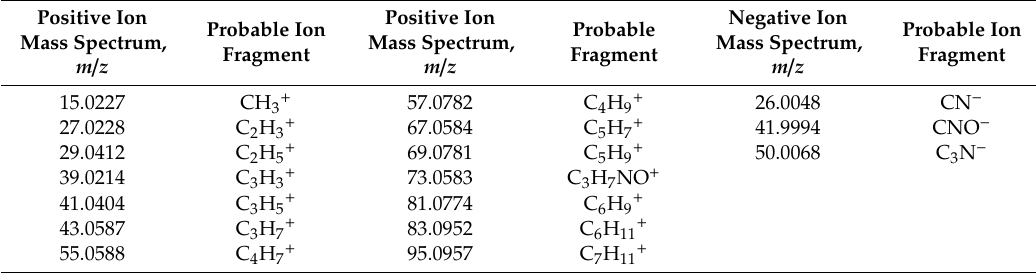
Table 3. Selected peaks and their assignment observed in positive- and negative-ion time-of-flight secondary ion mass spectrometry (TOF-SIMS) spectra of investigated